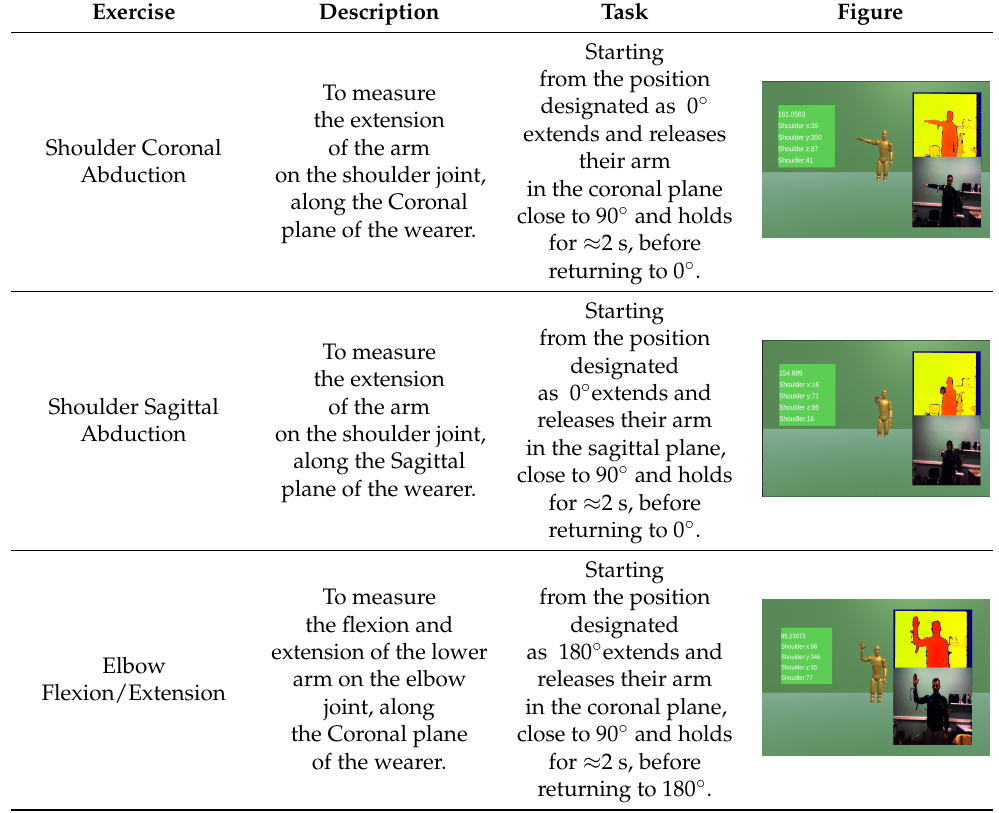
Table 1. Validation experiment—MARG sensor angles